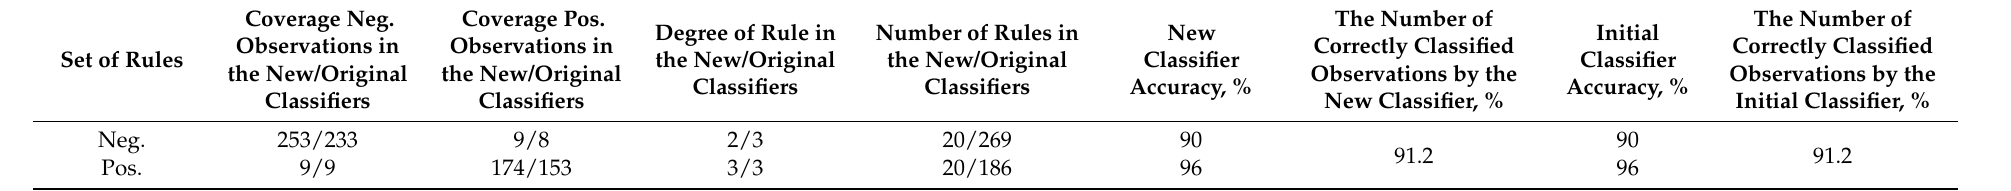
Table 3. Comparison of the classifier accuracy with different baseline observations to build patterns (problem of breast cancer diagnosis).